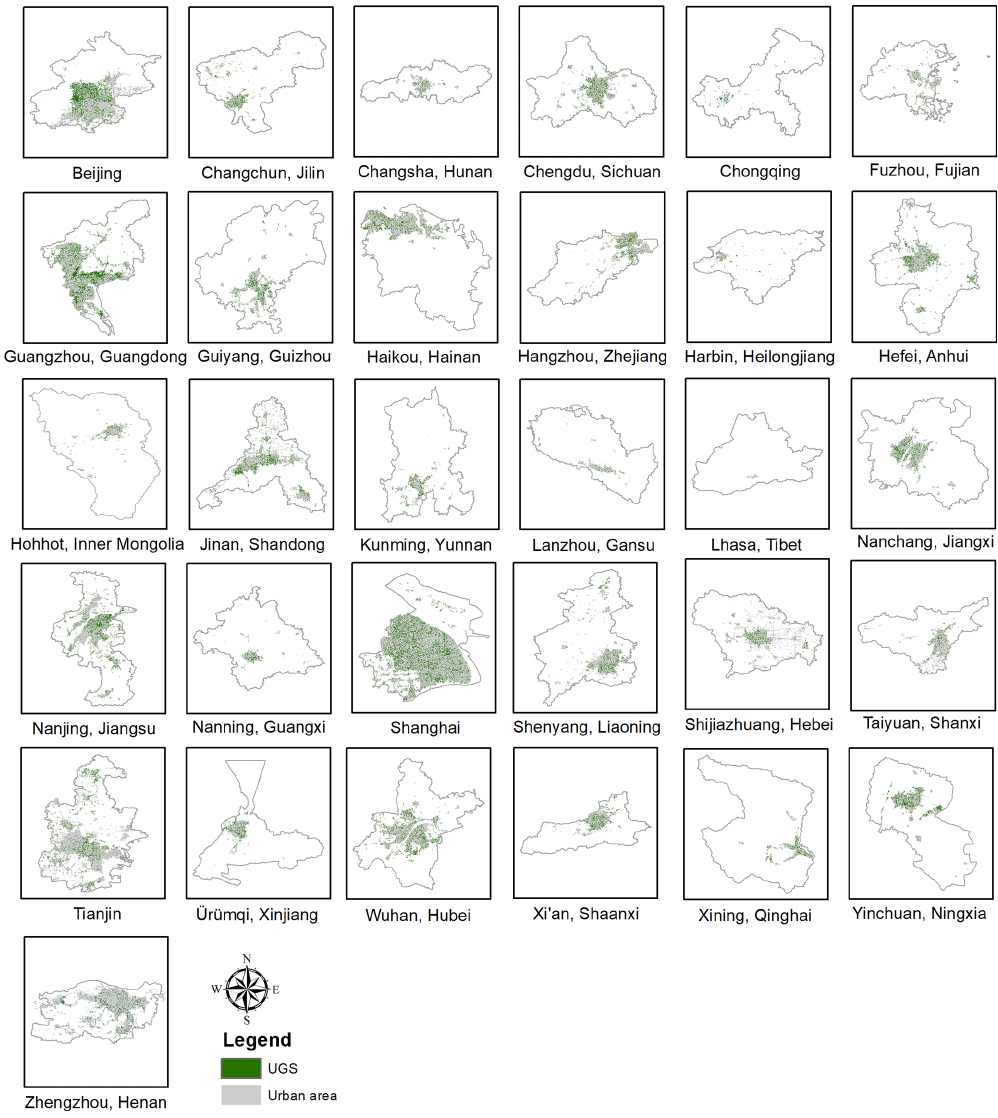
Figure 9. UGS results of the 31 major cities in China (UGS-1m). The urban area is from the GUB data (Li et al.,